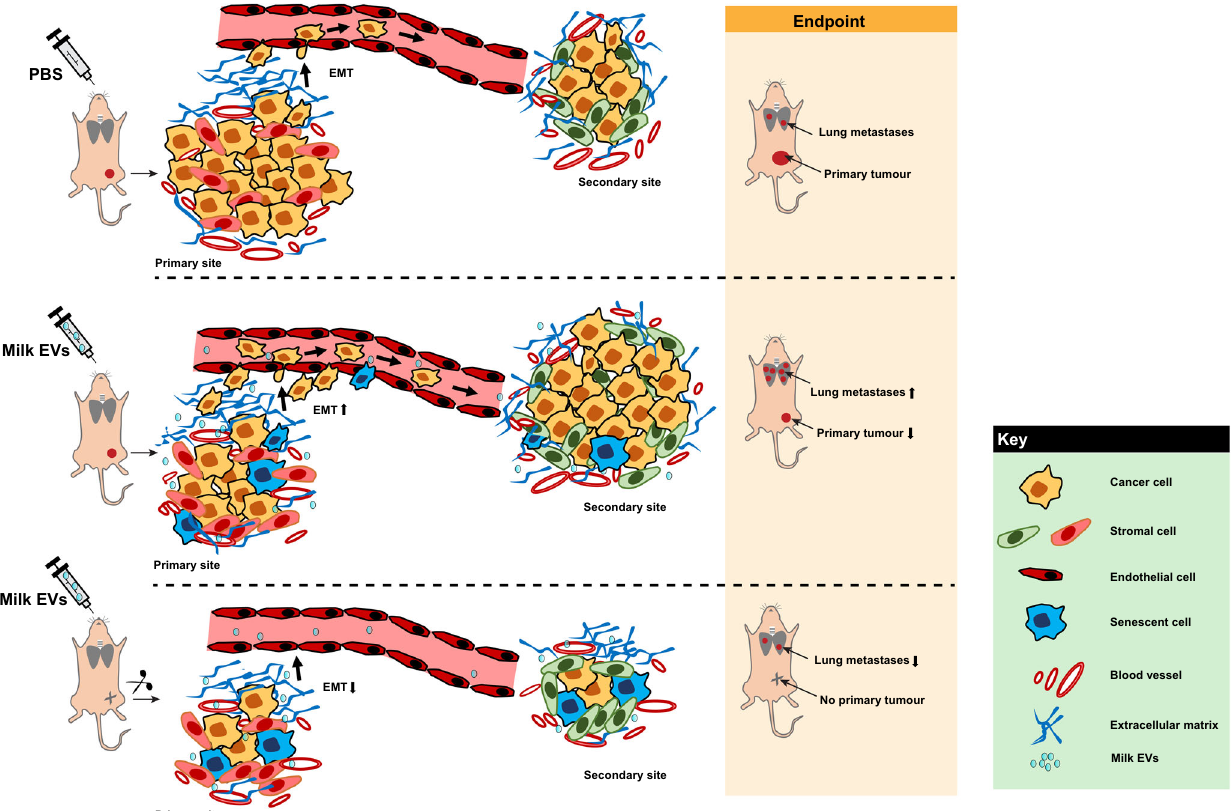
Fig. 8 Summary of the study. Orally administered milk-derived EVs can reduce the primary tumor burden and accelerate metastasis in a context- dependent manner. Milk EVs can induce senescence and EMT in the primary tumor thereby allowing for reduction in primary tumor and acceleration of metastasis. When the primary tumor is resected, milk-derived EVs induce senescence in the metastatic site thereby reducing the proliferation of cells seeded in distant